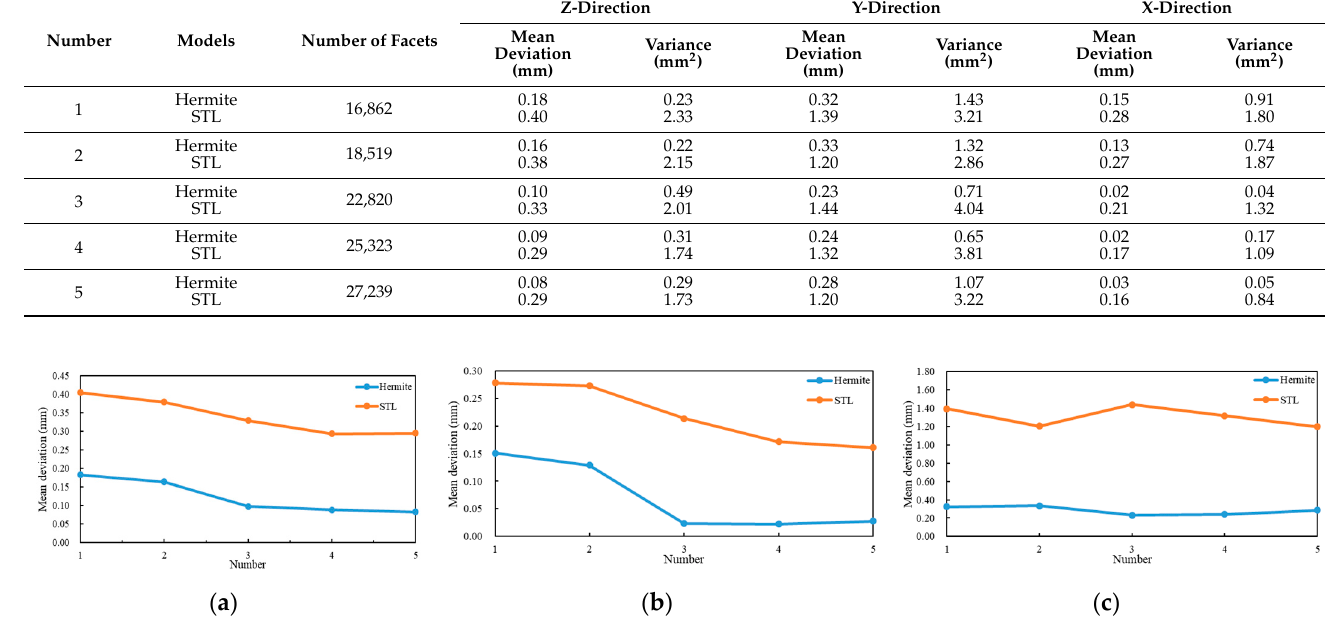
Table 4. Fitting error results after removing the “noise” from the rabbit model.